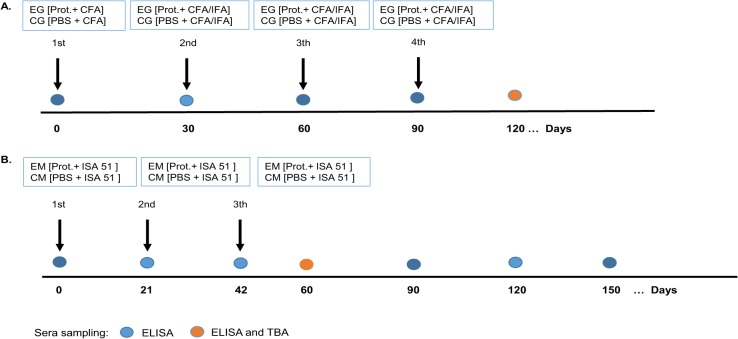
Immunization Schedule.For: A. Mice, animals were immunized four times at 30 days interval with 20 μm of Pvs48/45 formulated with Freund Adjuvant. Blood samples were taken on days 0, 30, 60 and 90 for ELISA testing and on day 120 for functional and biological assessing. B. Monkeys, two experimental animals were immunized with 50 μg of Pvs48/45, and one control group with PBS emulsified in 1:1 with Montanide ISA 51 Adjuvant. Protein was administrated subcutaneously in the back at 20 days intervals, blood samples were taken before each immunization, 15 days after the third immunization and then at 30 days intervals until day 150. EG: Experimental group; CG: Control group; CFA: Freund Complete Adjuvant; IFA: Freund Incomplete Adjuvant; EM: Experimental Monkeys, CM: Control Monkey, ISA 51: Montanide ISA 51 Adjuvant, Prot. Pvs48/45 protein.